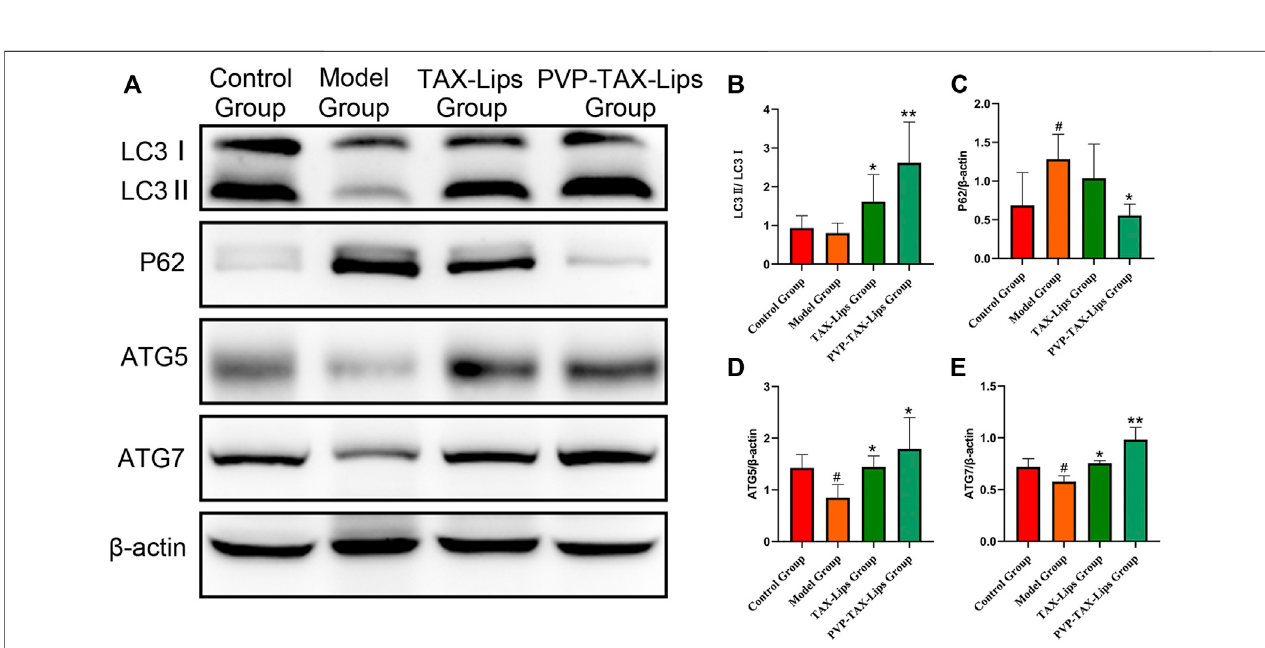
FIGURE7| Expressionoftheautophagyproteins inducedbyLPS/D-GalN. (A) ProteinlevelsofLC3, P62,ATG5,ATG7, and β -actin analyzed byWestern blotting. (B – E) Relative band intensity analyzed byImageJ Analysis System, and β -actin was used as a control for equal loading. As compared with the control group, # p < 0.05. As compared with the model group, * p < 0.05, ** p < 0.01. The data are presented as the mean ± SD ( n = 3).